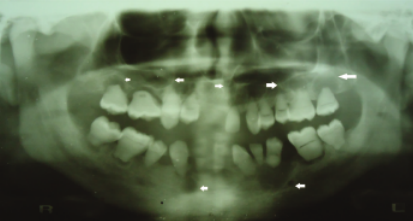
Figure2:Croppedpanoramicradiographshowinggeneralizedshortandtaperedroots,pulpalobliteration,horizontal/crescentshapedpulpal remnants in pulp chambers, and multiple periapical radiolucencies (white